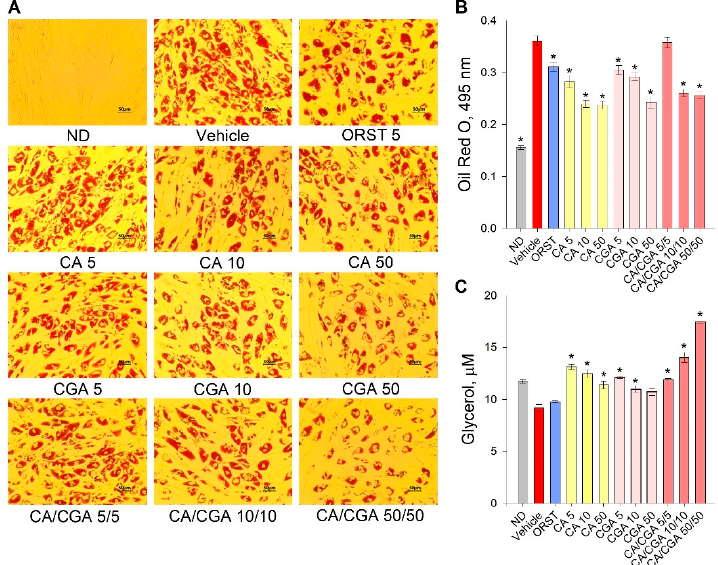
Figure 2. Caffeic and chlorogenic acids decreased lipid accumulation and enhanced glycerol release in human Simpson–Golabi–Behmel syndrome (SGBS) adipocytes. Representative pictures captured with 20× magnification (scale bar 50 µm) after the Oil red O staining ( A ). Absorbance of the Oil red O solution at 495 nm ( B ). Free glycerol concentration (µM) in the cell culture media ( C ). Data are expressed as mean ± SEM; each experimental group consisted of at least six technical replicates from three independent biological experiments. * p < 0.05 compared to vehicle control group.